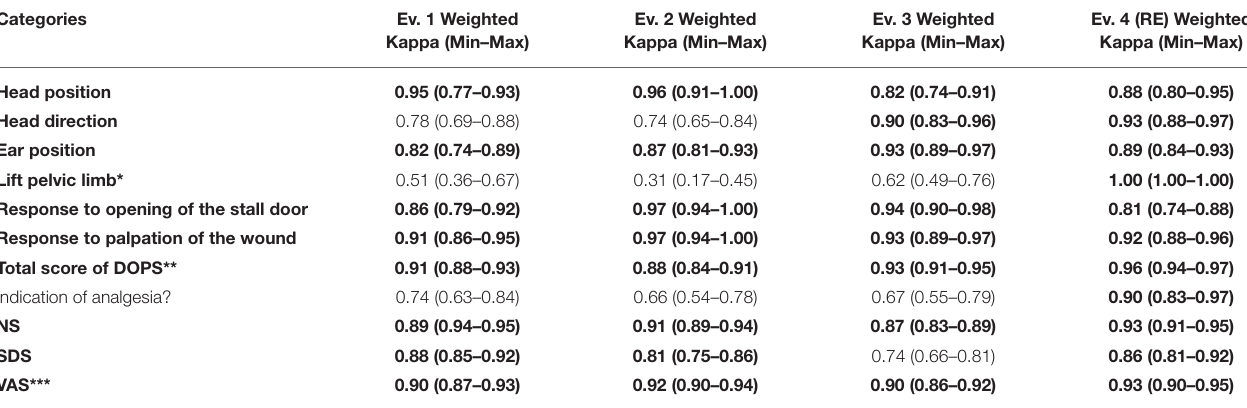
TABLE 7 | Repeatability (intra-rater reliability) of the DOPS and unidimensional scales to evaluate pain in donkeys submitted to